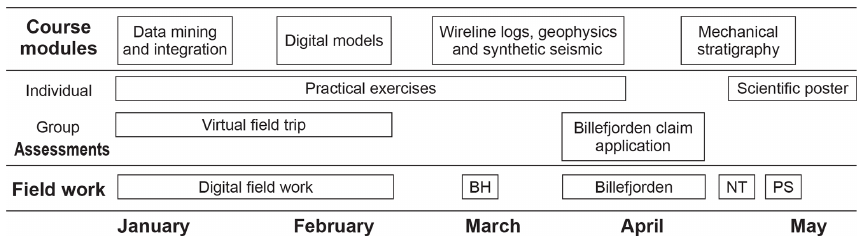
Figure 5. Overview of the central elements in the AG222 course; see Tables 2 and 3 for details. The four course modules are organized to build on each other, with skills learnt in the first half of the course highly relevant for the second half. The two main graded group assessments are very intensive within a relatively short period, while the graded individual assessment spans the entire semester giving student’s flexibility to manage their time. Field campaigns naturally follow the season, and each campaign has a clear learning objective. BH represents Botneheia day field trip, NT represents near town, PS represents Polarsyssel (boat excursion on Isfjorden). Table 2. Overview of the AG222 course